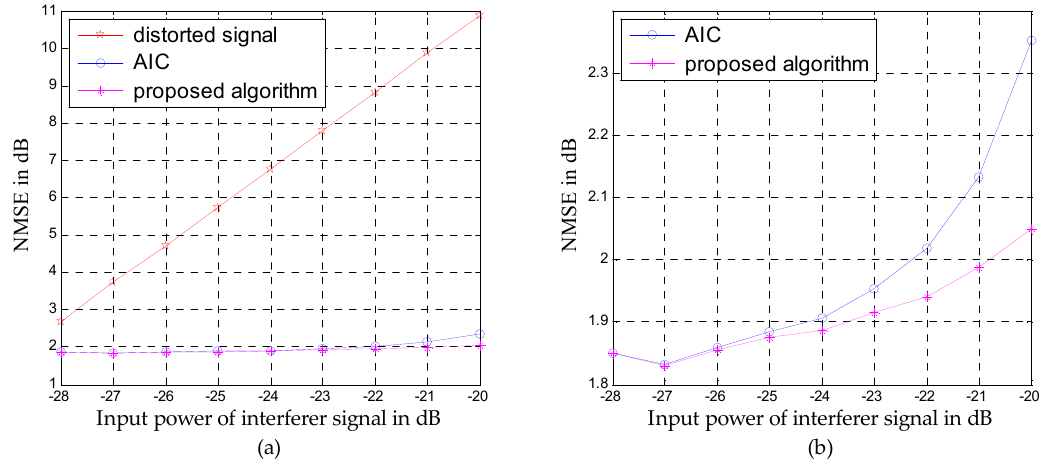
Figure 9. Normalized mean squared errors (NMSEs) of the weak desired signals at different input power levels: ( a ) comparison of the unmitigated signal with the outputs of AIC and the proposed algorithm; ( b ) comparison between the outputs of AIC and the proposed algorithm.